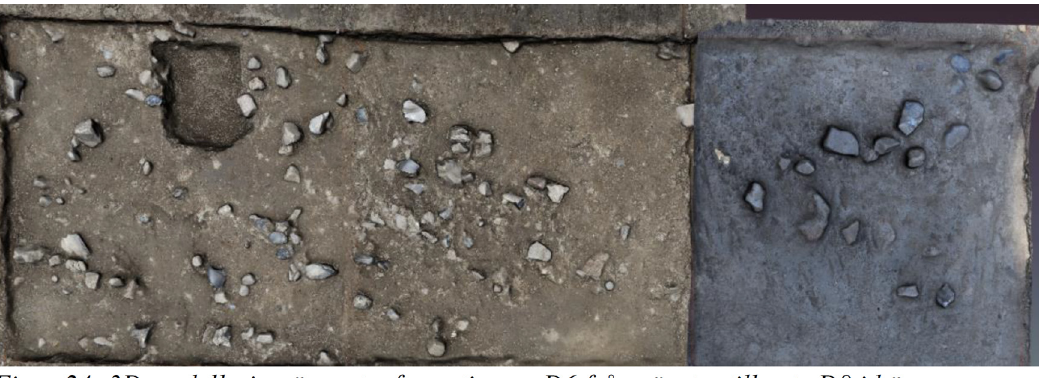
Figure 4: The picture, taken from one of the reports ( Bergman et al., 2019 ) , shows the students ’ use of IVS/3DHOP to visualise the extension of the stone layer in three units. They have combined 3D models of their own unit and the neighbouring group ’ s